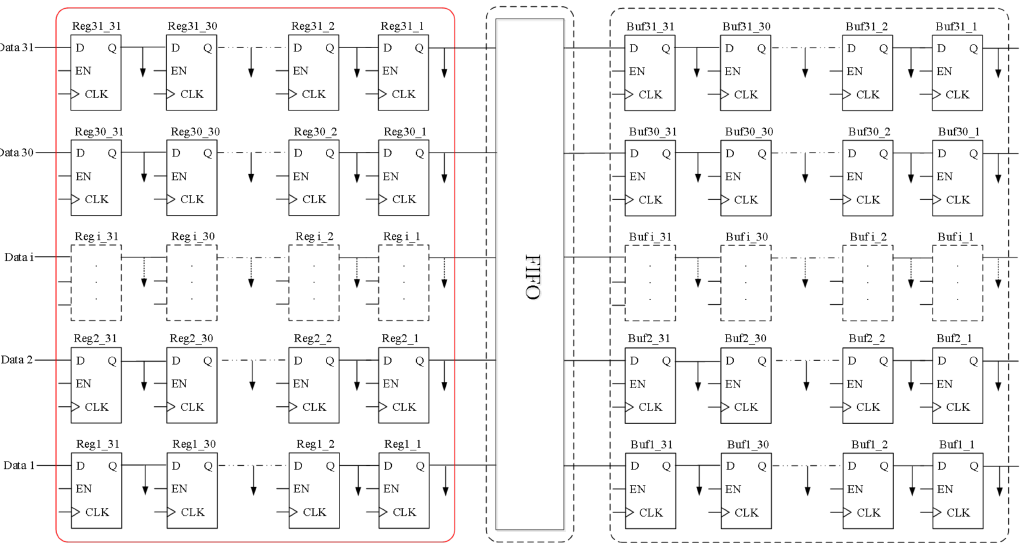
Figure 13. Serial shift register groups of the search